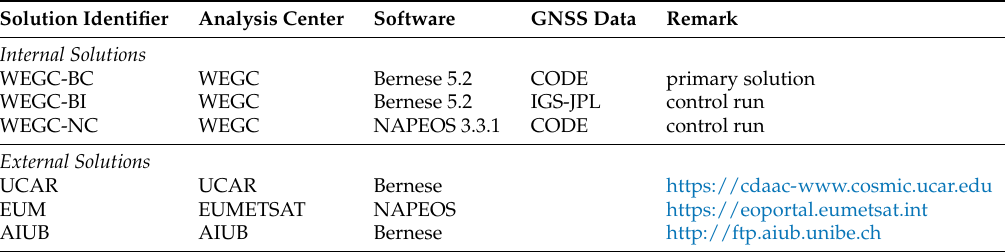
Table 2. Orbit solutions and metadata used in this